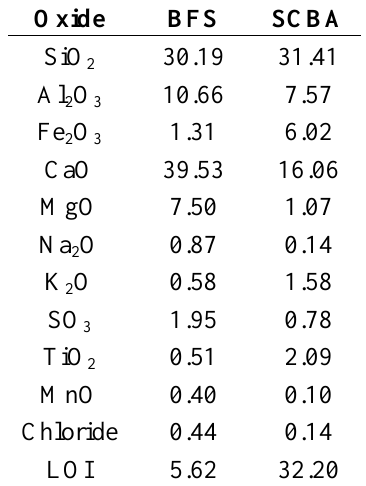
Table 1. Chemical composition of Blast Furnace slag (BFS) and Sugar Cane Bagasse Ash